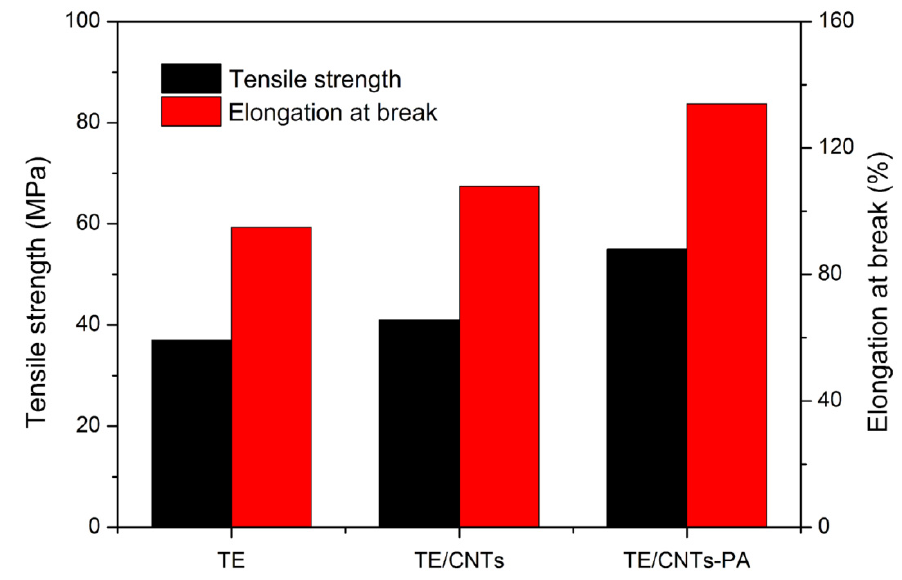
Figure 9. Mechanical properties of TE nanocomposites.